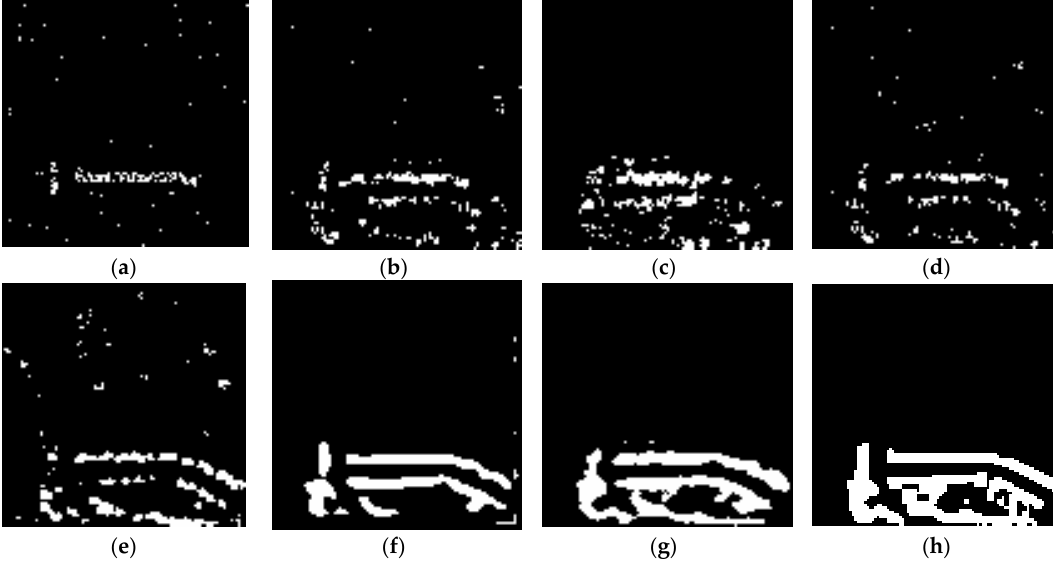
Figure 24. The change detection maps of different methods for the PolSAR-San Francisco2 dataset. ( a ) CVA-SVM, ( b ) MAD-SVM, ( c ) PCA-SVM, ( d ) IR-MAD -SVM, ( e ) SFA-SVM, ( f ) 3D-CNN, ( g ) Proposed Method, and ( h ) Ground Truth. White and black colors indicate the change and no-change areas, respectively.